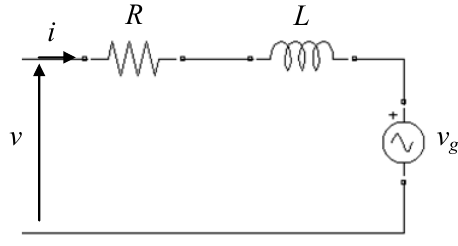
Figure 1. Basic RLE circuit model for one